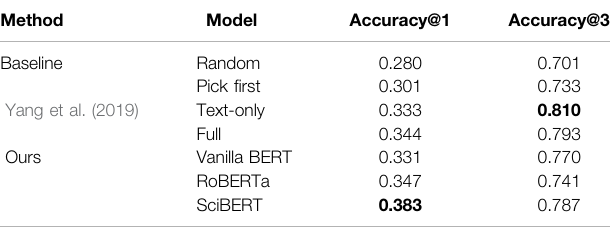
TABLE 2 | Performance of vanilla BERT, RoBERTa and SciBERT on the PubMed data set (Yang et al., 2019). We report Accuracy@1 and